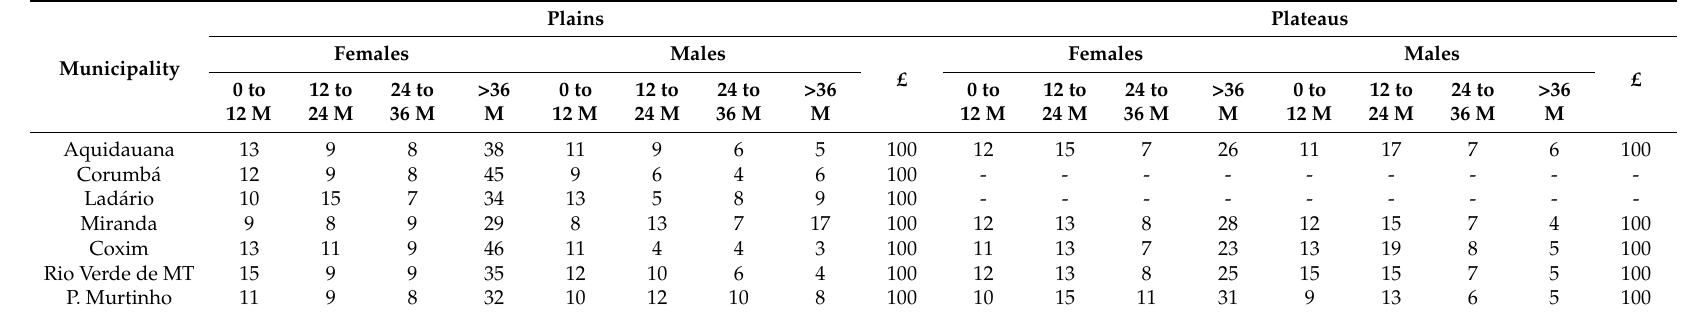
Table 1. Relative composition of South Pantanal herds in 2014